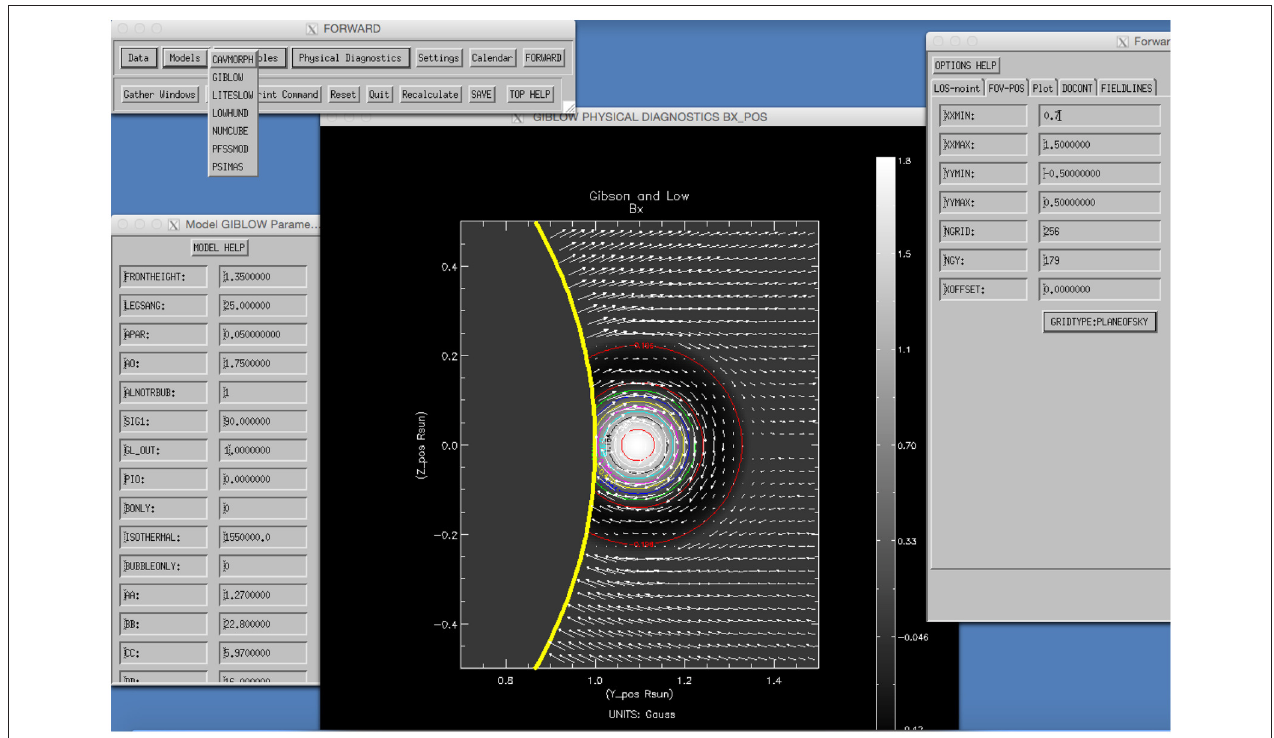
FIGURE 2 | Example of analytic model of a spheromak flux rope embedded in an otherwise open bipolar global magnetic field (Gibson and Low, 1998), provided within the FORWARD distribution and demonstrated here using the for_widget interface. The user chooses the model via the drop-down menu in the top-left widget as shown, and then may choose model parameters (bottom-left widget), and display (as in line-of-sight magnetic field example shown here) model diagnostics (top-left widget, drop-down menu for Physical Diagnostics ) with various plotting choices such as plane-of-sky field lines (white vectors; set in right widget). Doing an actual forward calculation of a coronal observable (not shown) is done by choosing one of the Observables (top-left widget, drop-down menu). All calculations are intitiated by clicking on the FORWARD button (top-left